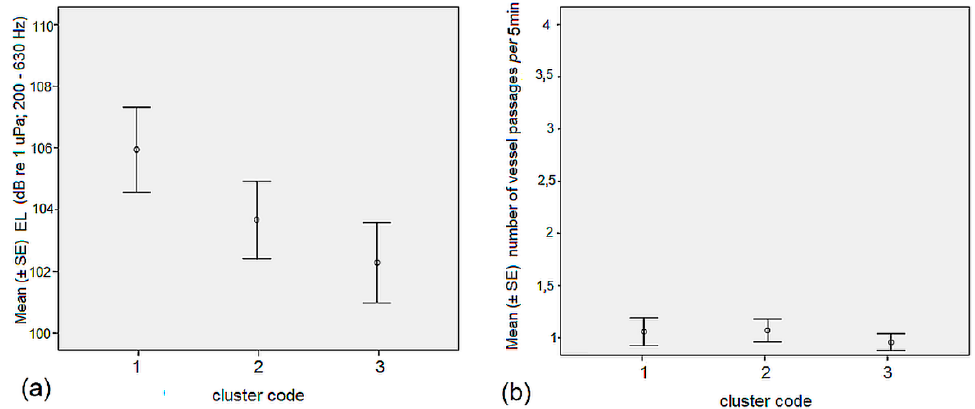
Figure 7. Mean ( ± standard error) ( a ) noise levels (EL 200–630 , dB re 1 µ Pa) and ( b ) number of vessel passages at the listening Figure 7. Mean (±standard error) ( a ) noise levels (EL 200–630 , dB re 1 μ Pa) and ( b ) number of vessel passages at the listening points belonging to the three groups highlighted by cluster analysis for points belonging to the three groups highlighted by cluster analysis for the night the night recordings.